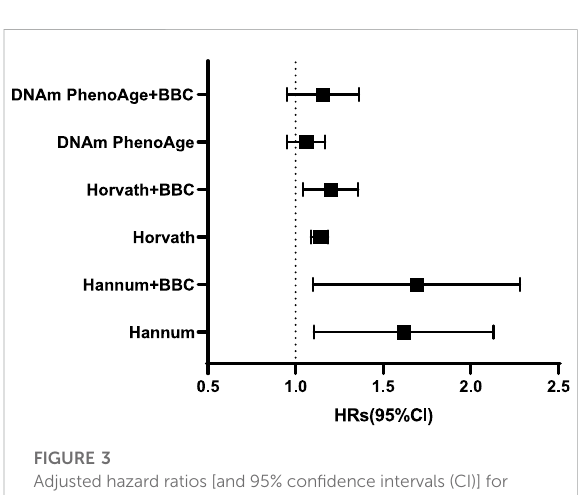
FIGURE 3 Adjusted hazard ratios [and 95% con fi dence intervals (CI)] for the epigenetic age